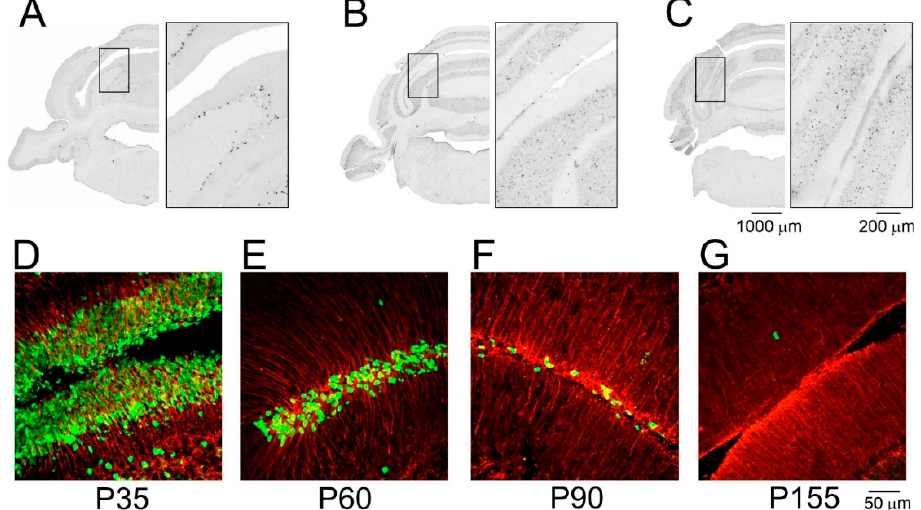
Figure 2. Origin of cerebellar cells in the opossums Monodelphis domestica . BrdU-labeled cells in the cerebellum of 3-month-old opossums that were injected at day 3 ( A ), 21 ( B ), and 60 ( C ) postnatally. BrdU-labeled cells (green) and GFAP (red) cells in the developing cerebellum that were injected with the dose of 75 mg/kg BrdU twice at postnatal days (P) 35 ( D ), P60 ( E ), P90 ( F ), and P155 ( G ). Opossums were sacrificed 4 h after the first injection of BrdU. Modified figure from our previous article [29].